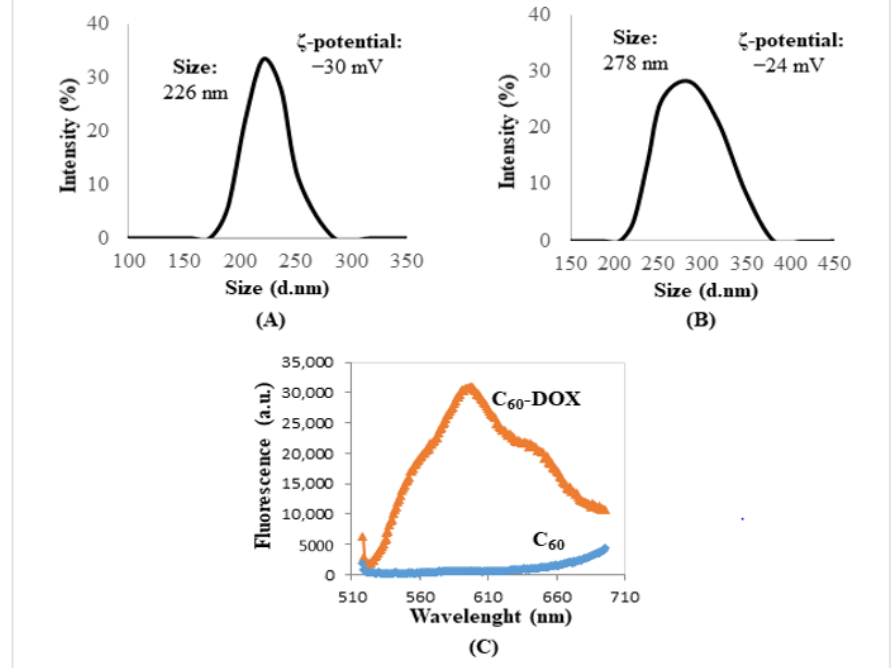
Figure 1. Biophysical characterization of the fullerene (C 60 ) and complexes of C 60 –doxorubicin (DOX) . Size and zeta potential of the C 60 ( A ) and C 60 –DOX complexes ( B ). ( C ) Fluorescence spectra of C 60 –DOX complexes (concentration of fullerene: 25 mg/mL)—measured immediately after their preparation without further specimen processing. For other experimental conditions, see Material and Methods. ζ —zeta; C 60 —fullerene; DOX—doxorubicin.